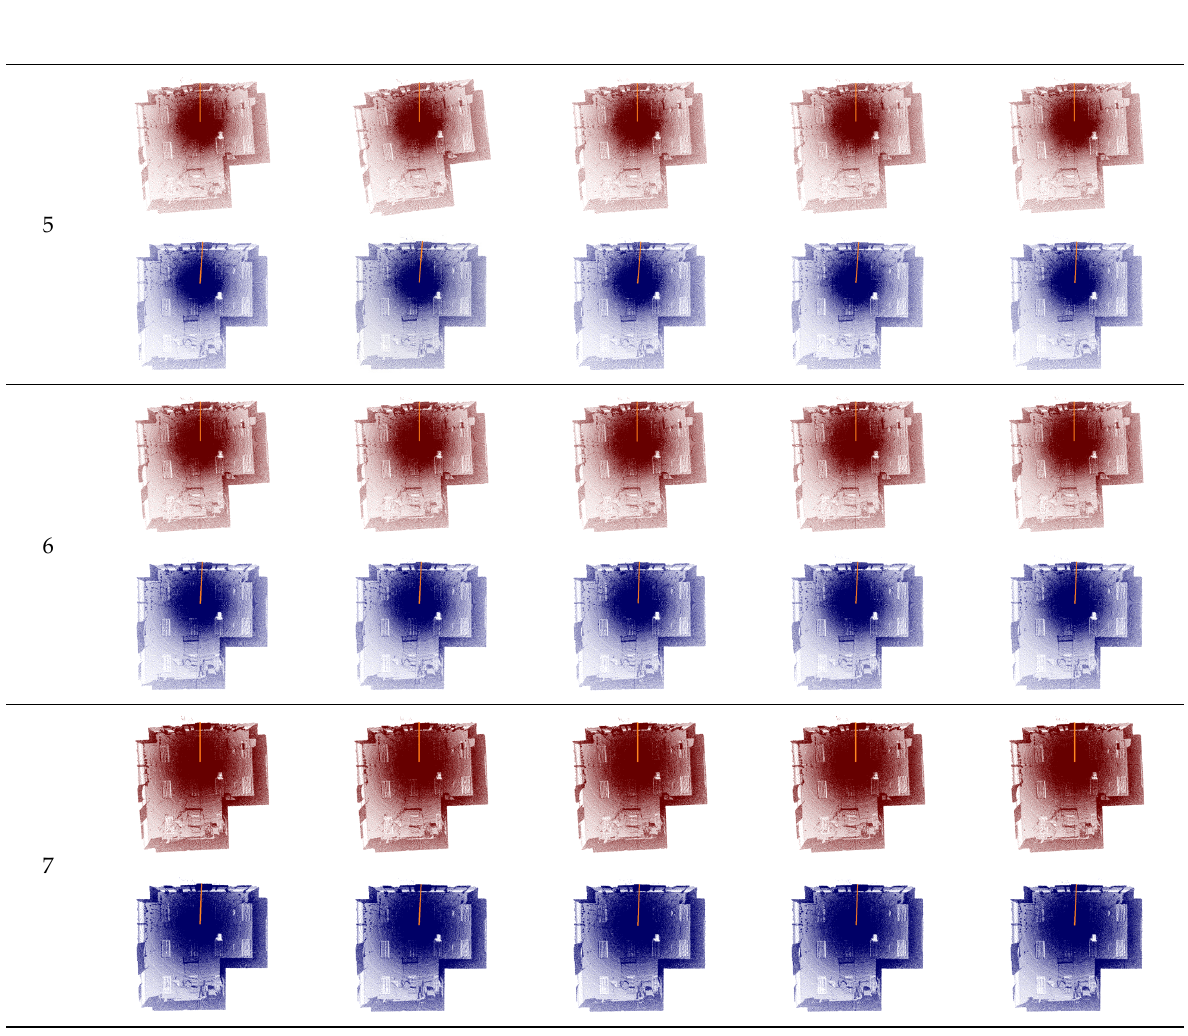
Figure 8. Top views of 70 3D point clouds.